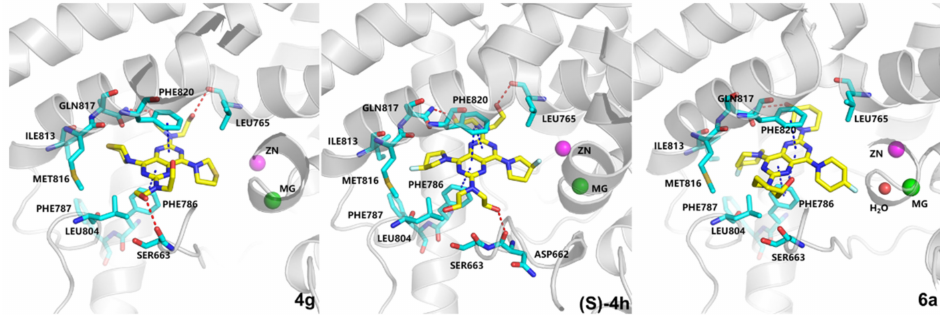
Figure 3. Putative binding modes of compounds 4g , ( S )-4h and 6a with PDE5 in molecular dock- ing